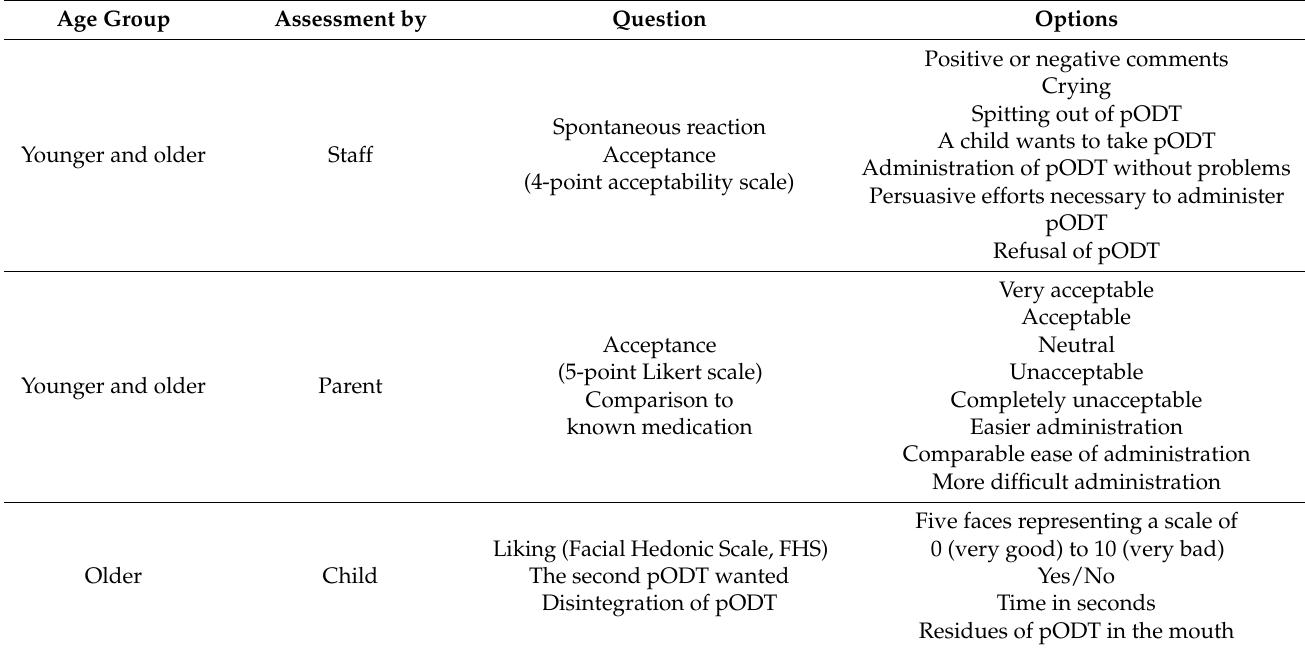
Table 1. Study design and assessment. The term ‘Acceptable’ is defined by the first two points on the Likert scales. Age group “younger”: 2–5 years of age, n = 20. Age group “older”: 6–10 years of age, n =